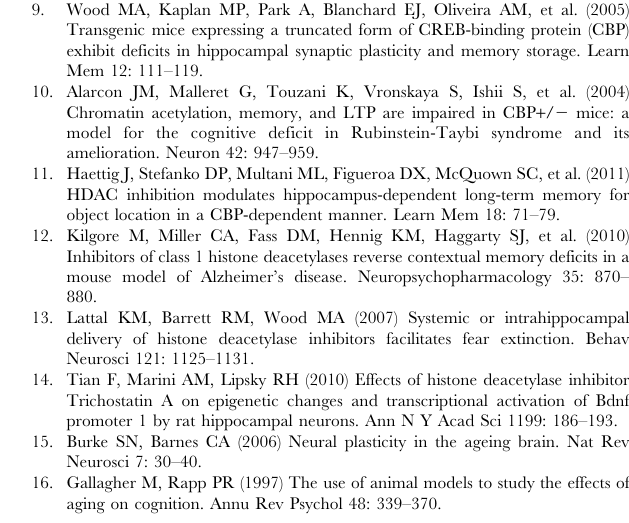
Figure S3 Differential cellular localization of HDAC1 and 2 immunoreactivity in the hippocampus. (A) Repre- sentative single channel and merged confocal microscope images